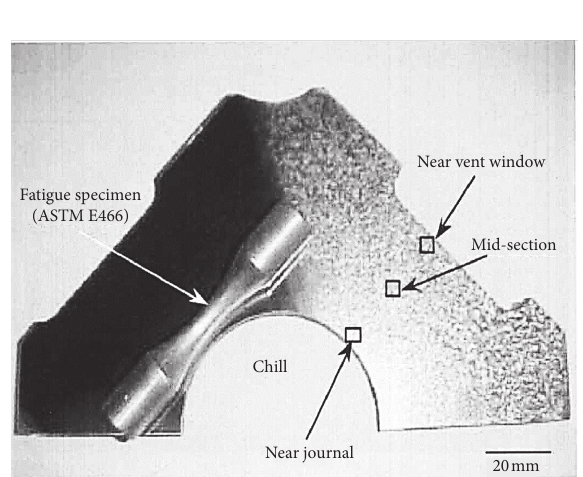
Figure 4: Positions of fatigue samples prepared from a V-shaped engine machine [24].